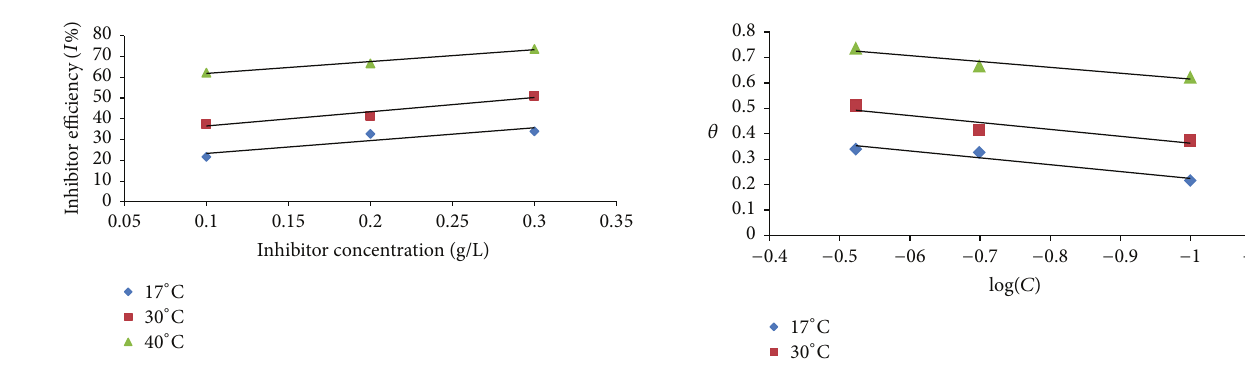
Figure 3: The inhibition efficiency ( 𝐼 %) against inhibitor con- centration for mild steel in 1MHCl containing GA at different temperatures.